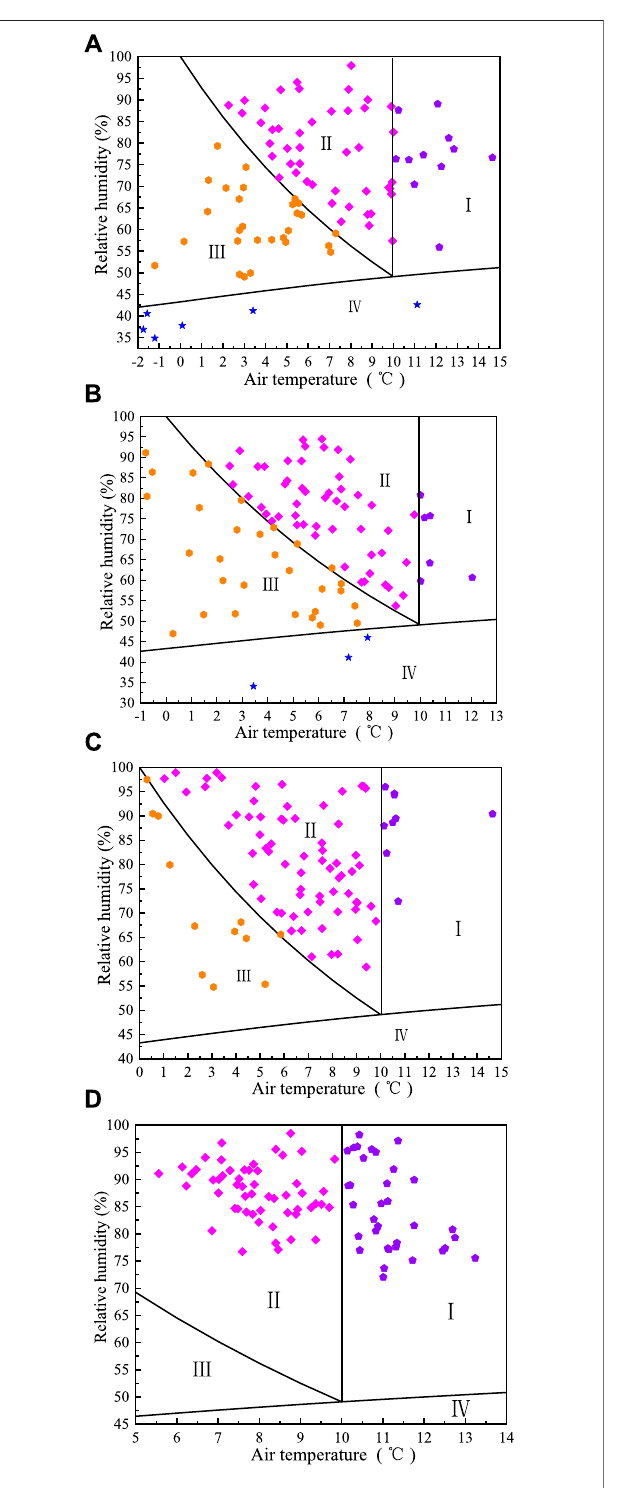
FIGURE 4 | Classi fi cation of the frosting types in Shanghai, Wuhan, Changsha, Chongqing, Xi ’ an, and Beijing in the temperature – humidity diagramandHarbininthethree-phasediagram: (A) Shanghai; (B) Wuhan; (C) Changsha; (D) Chongqing; (E) Xi ’ an; (F) Beijing; and (G) Harbin.